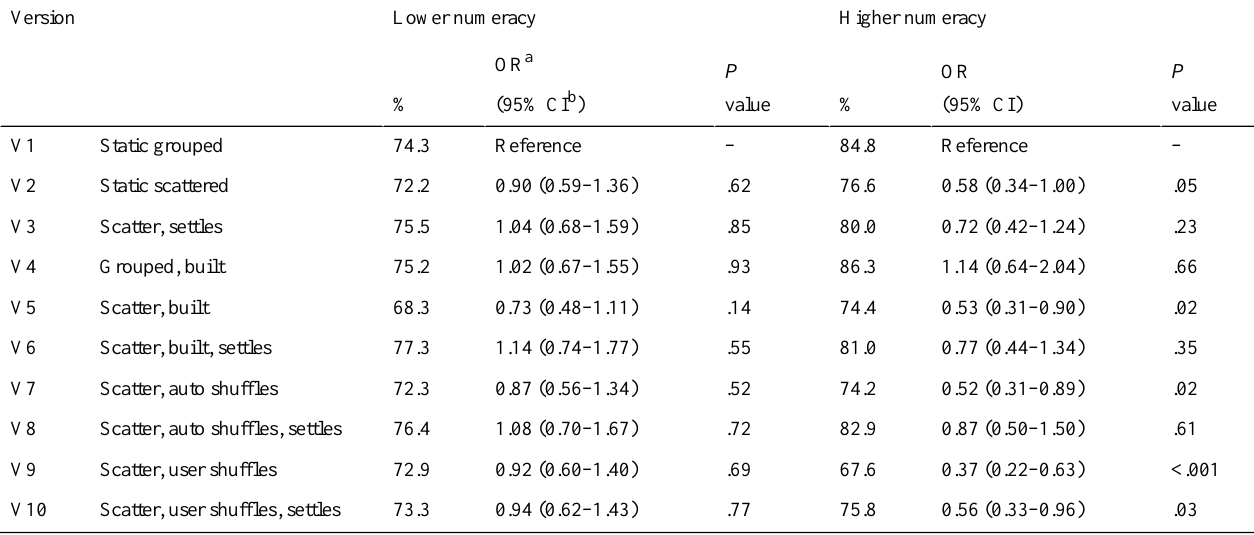
Table 3. Percentage choosing best treatment option, by graph version and respondent